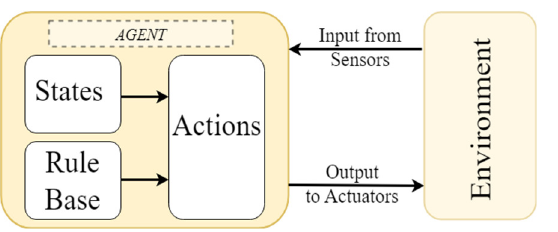
Fig. 3: Basic architecture of a software agent Detailed architecture of a typical software agent showing individual layers is shown in Fig. 4.